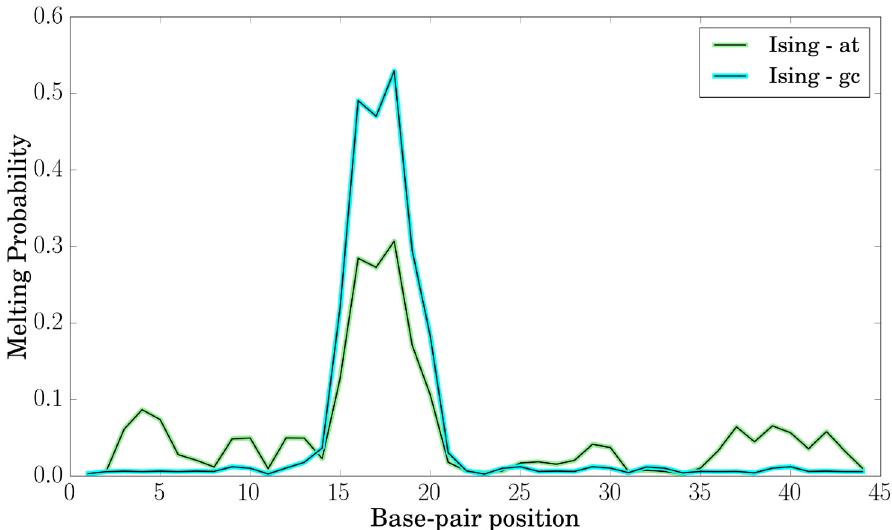
Fig 10. Calculated melting probabilities along the sequence using the Ising model at a global supercoiling stress of σ =